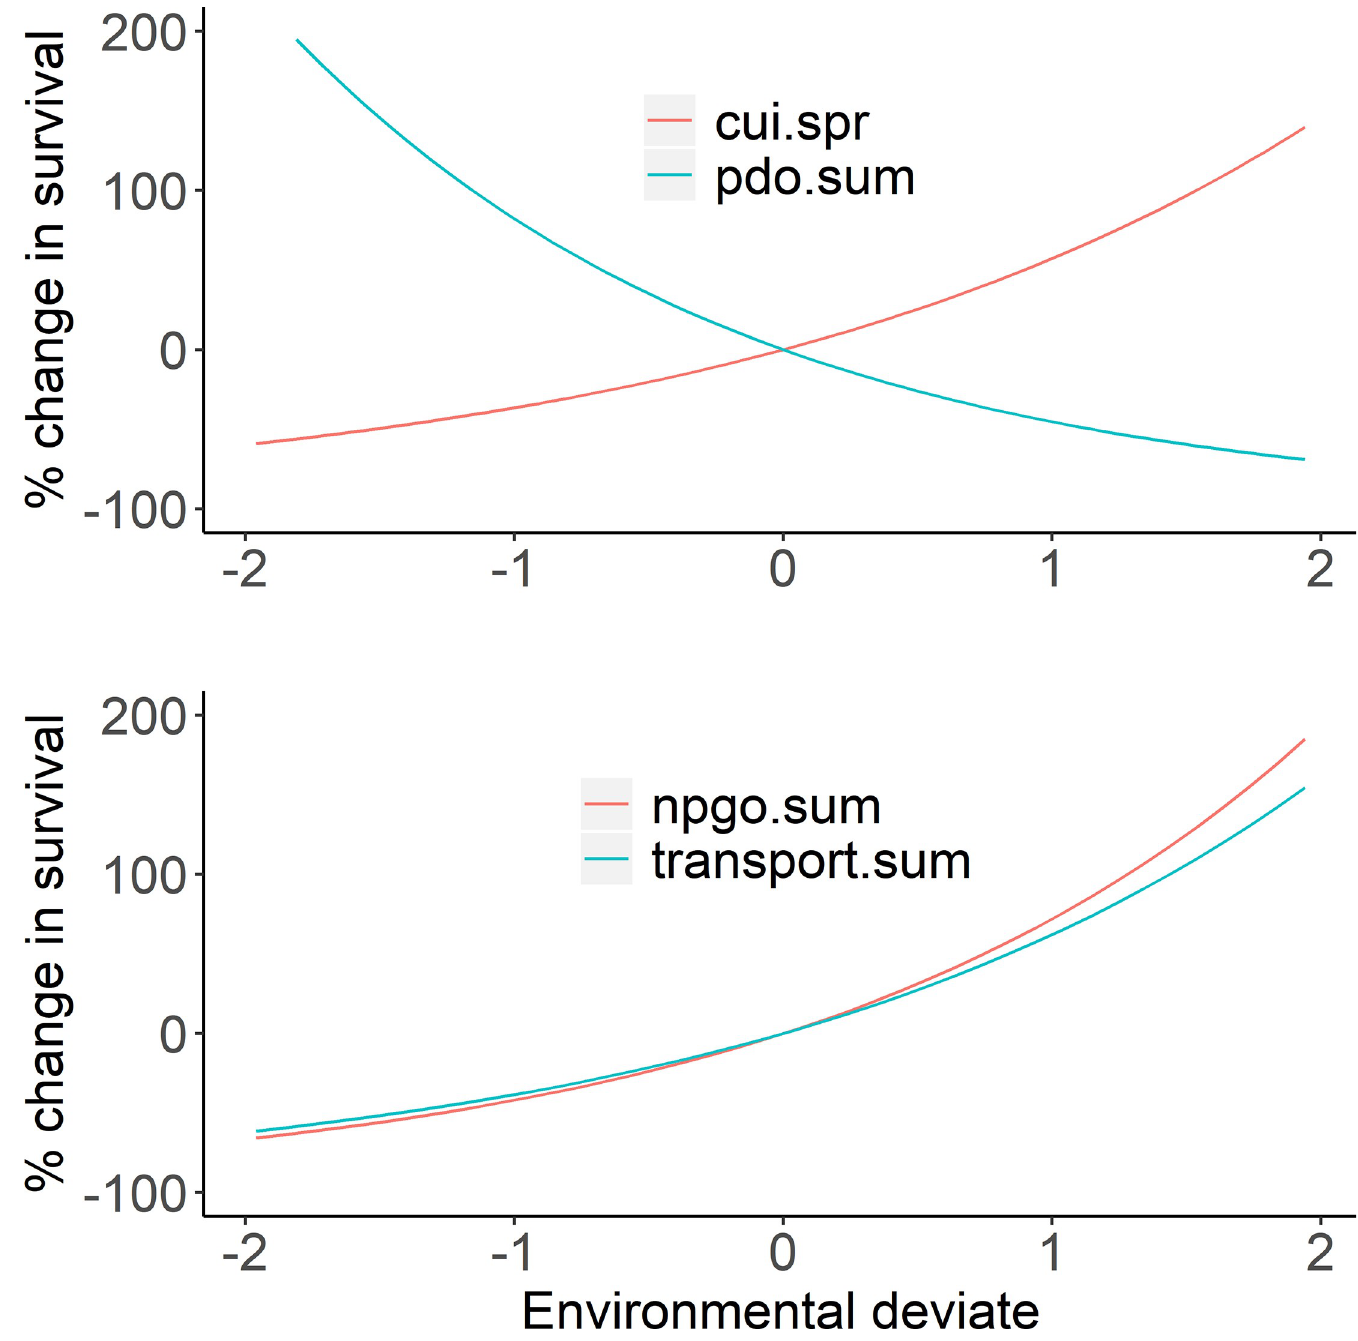
Fig 1. Effects of environmental covariates on spring/summer Chinook salmon survival. Environmental effects on survival of wild (upper panel) and hatchery (lower panel) spring/summer Chinook salmon based on the model fit to the observed data as selected by AIC (see Table 4 for summary of model fits).